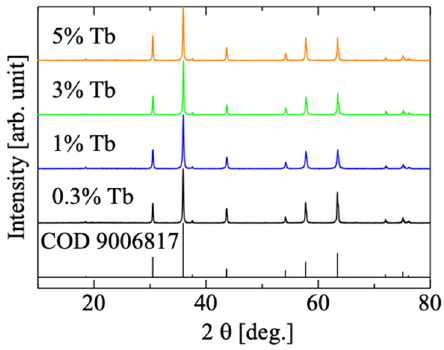
Figure 2. XRD patterns of synthesized Tb-doped MgGa 2 O 4 and reference (COD 9006817).